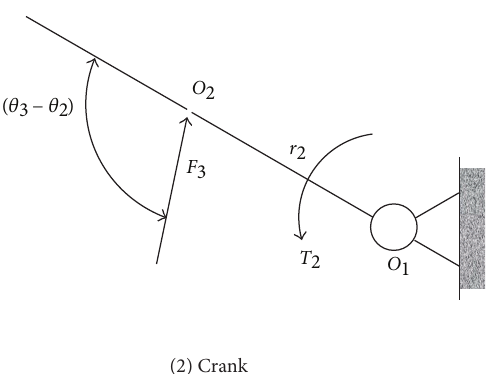
Figure 5: Variation of force transmission ratio with crank angle 𝜃 2